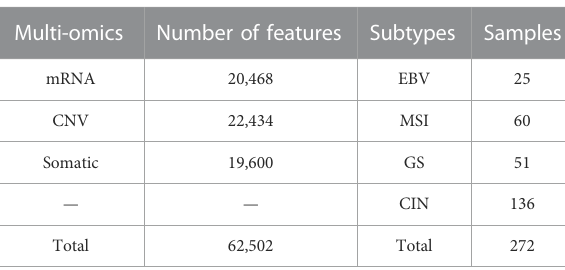
TABLE 1 Overview of the STAD